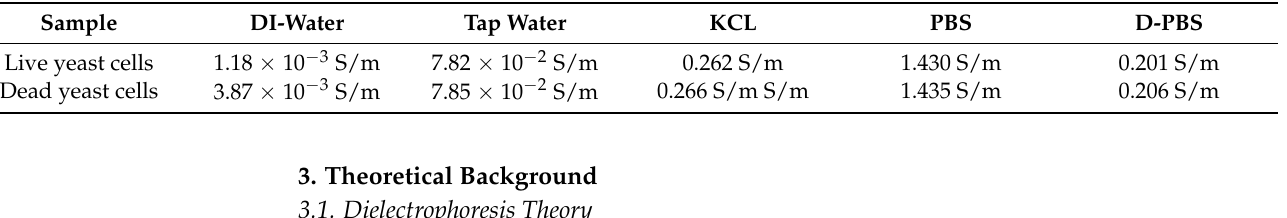
Table 2. Conductivity value of cell suspension